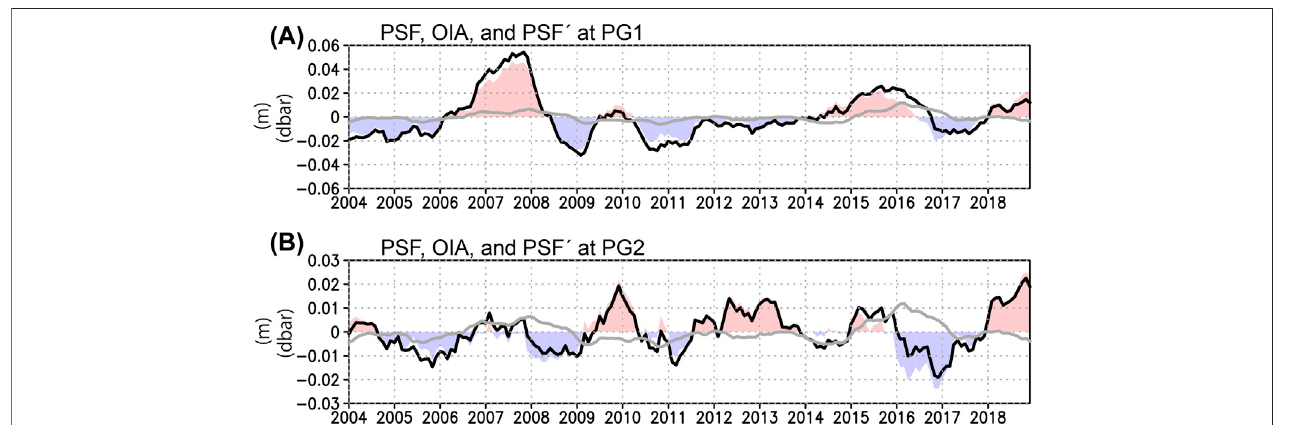
FIGURE9|(A) TimeseriesofOIA(inm;graysolidline),PSFanomalies(indbar;blacksolidline),PSFanomaliesaftertheOIAsweresubtractedfromtheoriginalPSF anomalies(PSF ′ )atPG1(colorshadesofredandbluecolors).A1-mchangeinOIAisalmostequalto1-dbarchangeinPSF.Here,weassumedthata1-mchangeinOIA isperfectlyequalto1-dbarchangeinPSFforcalculatingPSF ′ .OIAswerere-calculatedusingmonthlyclimatologiesfromJanuary2004toDecember2018,tomatchthe data length of the PSF at PG1 and PG2. (B) Same as (A) but for